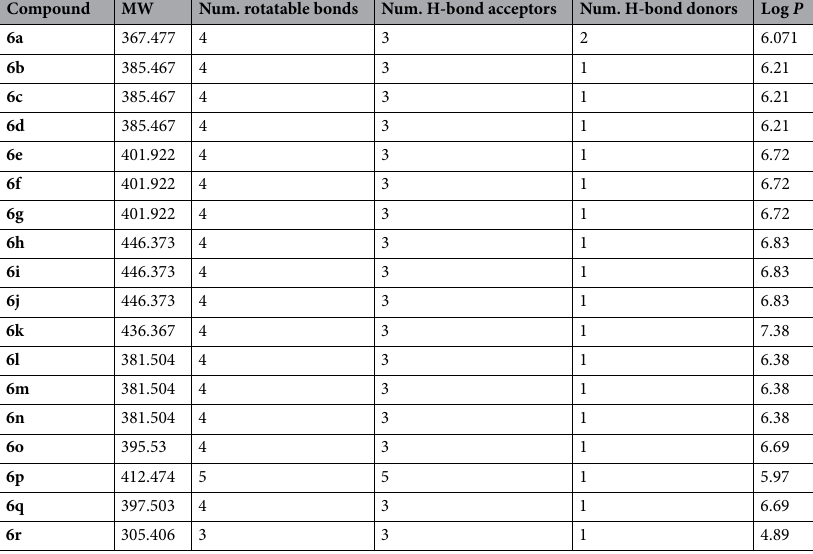
Table 4. Drug-likeness properties of